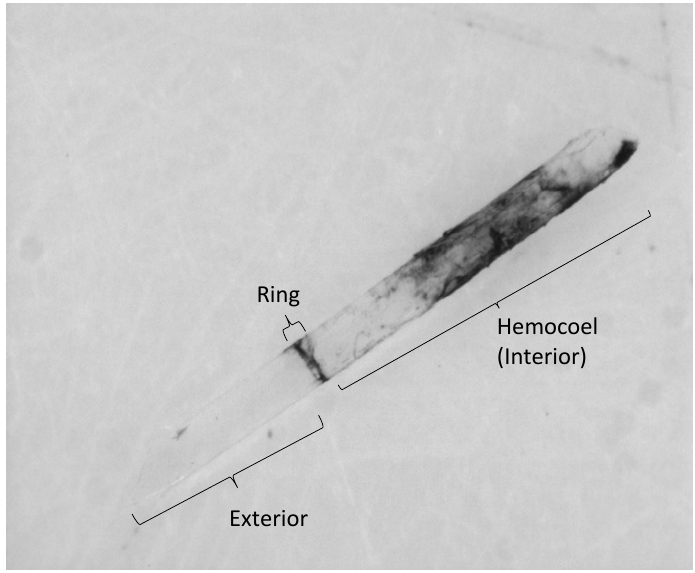
Figure 2. The encapsulation around a pseudo-parasite probe 4 h post-insertion. Three primary regions are identified: “exterior”, defined as the portion that remained outside of the hemocoel; “ring”, defined as the junction point between the external and internal environments of the bee; and “interior”, defined as the portion fully within the hemocoel. Encapsulation data was analyzed for the entire inserted portion (ring and interior) and the ring